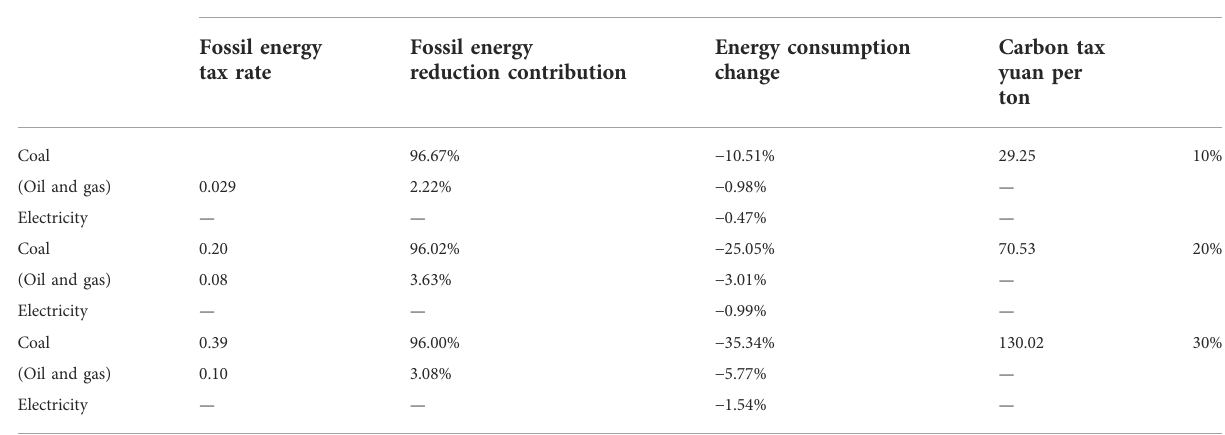
TABLE 2 Carbon tax strategy under different energy scenarios.